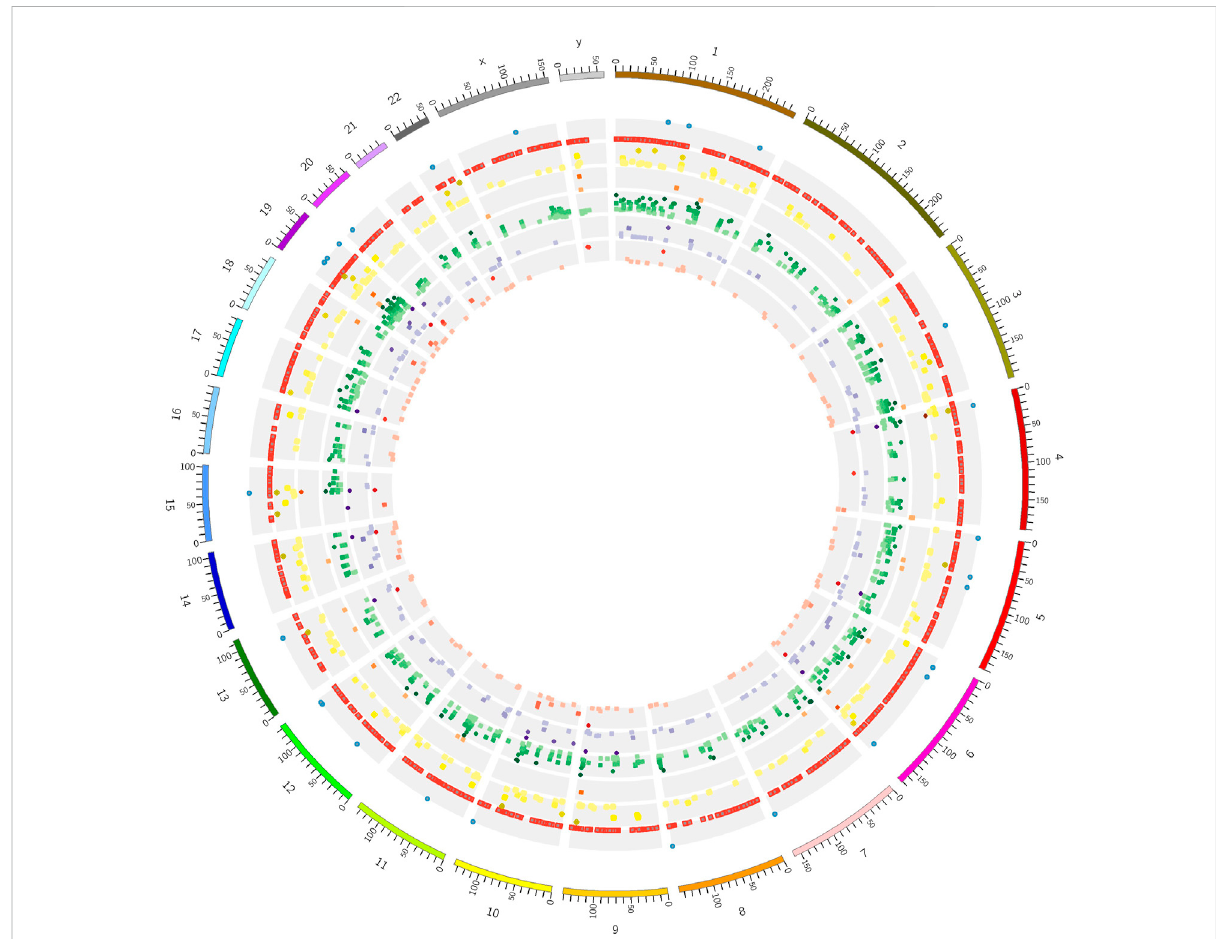
FIGURE 4 Overviewofnovelinsertionspredictedbythetoolsonthe50genomesinacircularchromosomalplot.Theorderofconcentriccirclesfromthe outside of the plot: circle 1 (blue dots) — known non-reference insertions; circle 2 (red dots) — known reference insertions; circle 3 (yellow): Retroseq predictions; circle 4 (orange): Retroseq plus predictions; circle 5 (green): Steak predictions; circle 5(purple) ERVcaller predictions, circle 6 (red): Melt predictions. The intensity of the color and the height of each dot in its band is proportional to the number of subjects in whom the insertion is predicted with darker colors and higher position corresponding to a larger